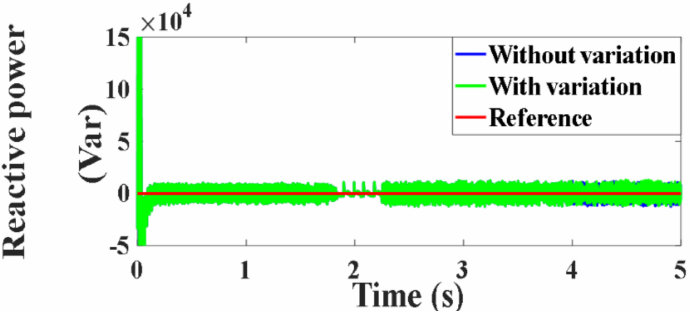
Figure 80. Reactive power under PVC (var).